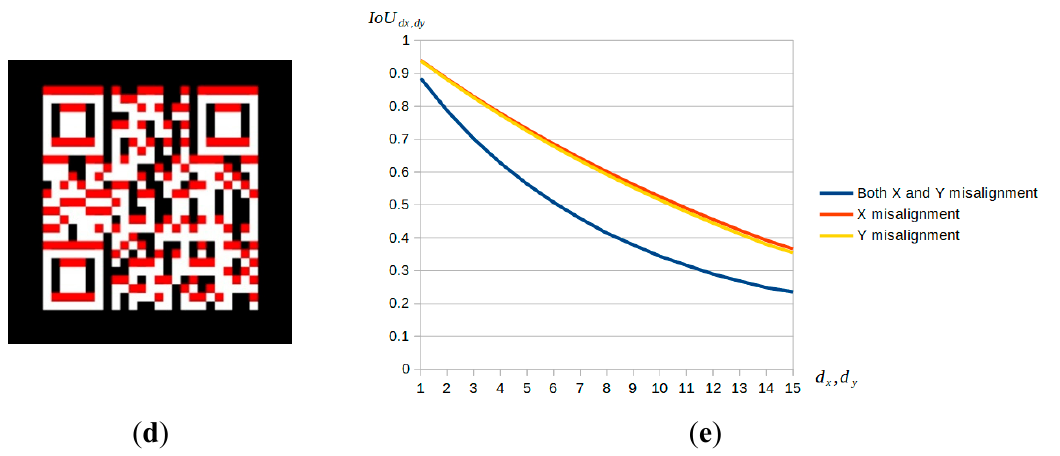
Figure 1. Quick response (QR) tags have rich textures, and even small misalignment can cause large IoU reduction. ( a – d ) display IoU 1,1 , IoU 15,15 , IoU 15,0 and IoU 0,15 respectively. Figure 2e shows the change curve of IoU dx , dy . The red, orange and blue curve show the change of IoU when d x goes from 1 to 15, d y goes from 1 to 15, and d x = d y goes from 1 to 15, respectively.